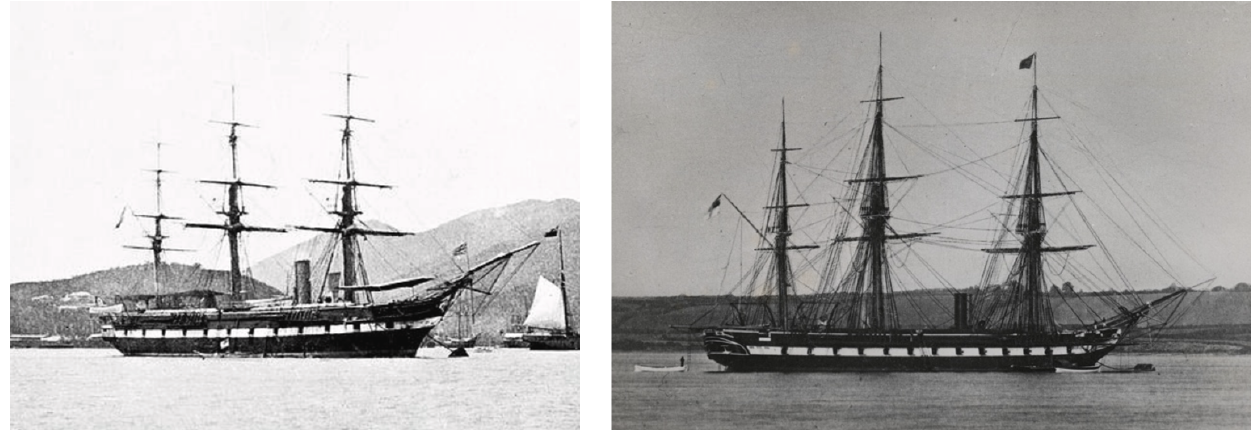
Figure 2. Left: HMS Challenger in St Thomas, West Indies, March 1873 (archives of the Natural History Museum, London). Right: SMS Gazelle (archives of Marineschule Mürwik, Germany). Table 1. The principal characteristics of HMS Challenger and SMS Gazelle